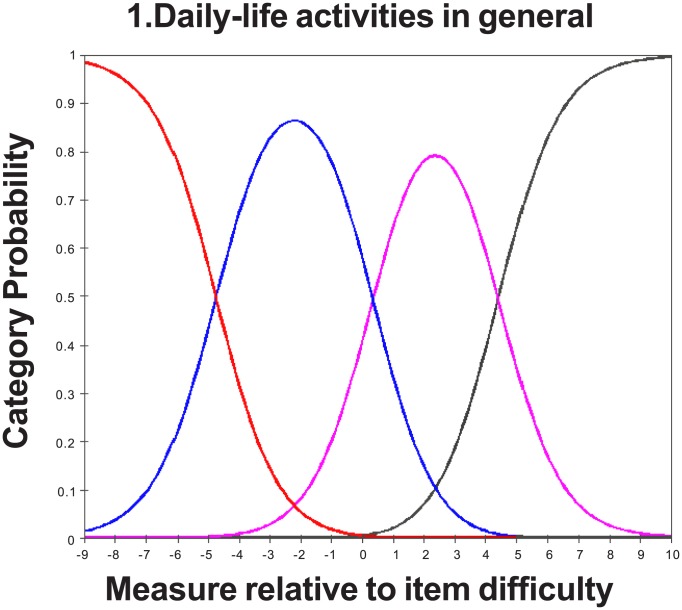
Category probability curves for the global “difficulties in your daily life” item, which illustrates ordered threshold.